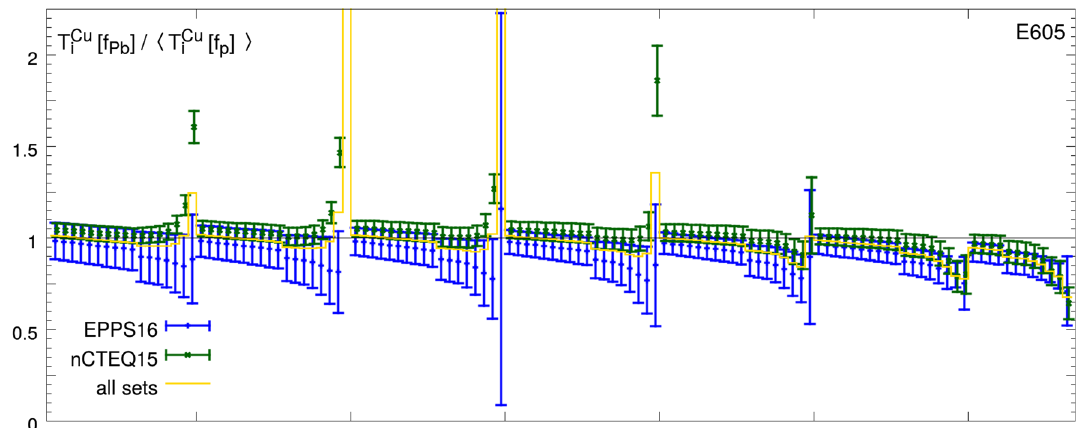
Fig. 6 Same as Fig. 4, but for E605. From left to right, there are seven bins corresponding to different values of the vector boson rapidity y : − 0.2, − 0.1, 0.0, 0.1, 0.2, 0.3 and 0.4. In each bin, the value of the